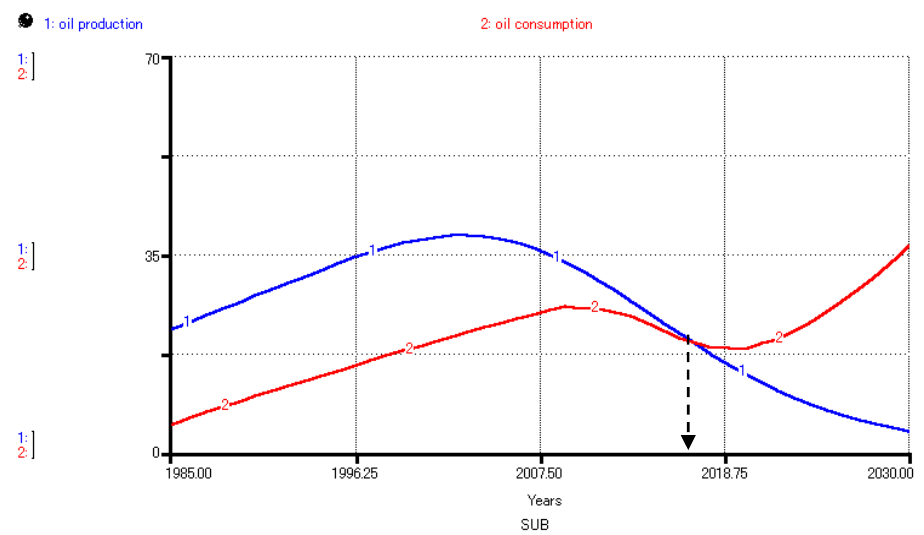
Figure 20. Oil production and consumption in SUB scenario.